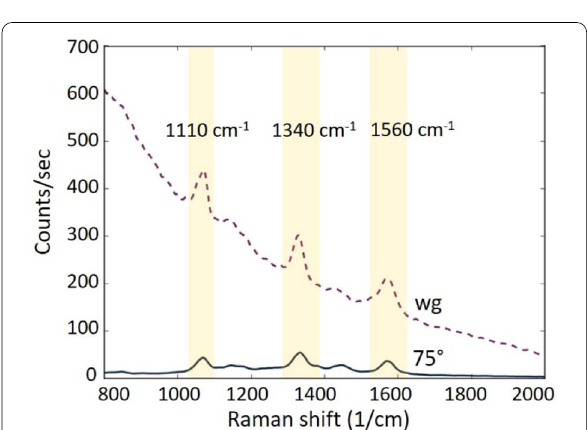
Fig. 17 The dashed curve is the measured back-scattered Raman spectrum with the waveguide mode excitation. The solid curve is the spectrum obtained for an oblique free-space excitation at an angle of 75°. The NTP Stokes peaks are highlighted by yellow shaded areas. Adapted with permission from Ref [65], Copyright © 2020,